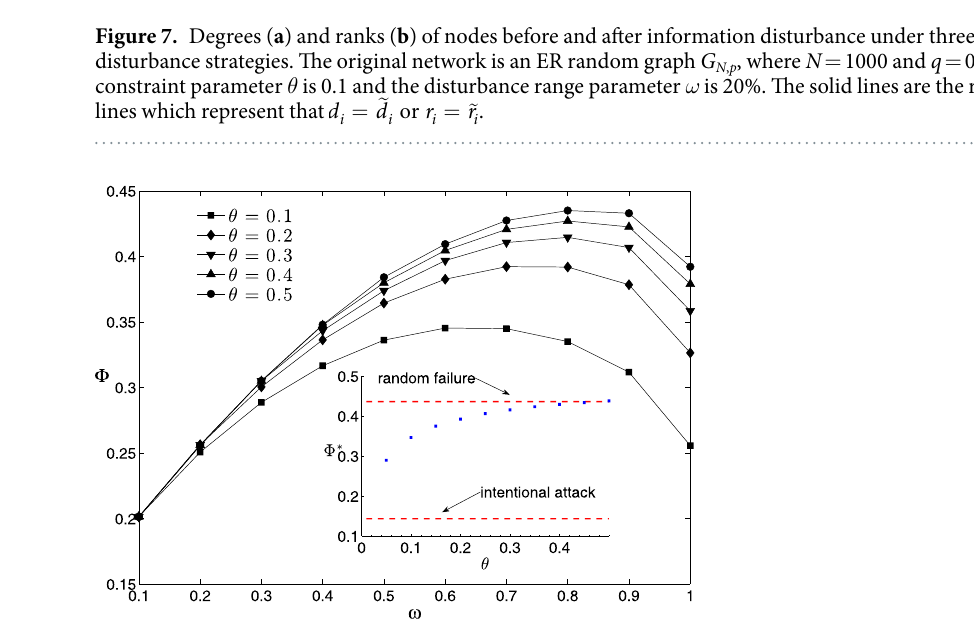
Figure 8. The disturbance effect Φ versus the disturbance range parameter ω under the “poor nodes strategy”. The original network is the same as the one we used in Fig. 2. The symbols represent the original experiment data, which are averaged over 100 realizations of disturbance strategy. The solid lines are obtained from the Kriging surrogate model. The insert shows the maximum disturbance effect Φ * as a function of the cost constraint parameter θ and the cases of random failure and intentional attack as references (dotted lines). The disturbance effect is obtained based on the structural robustness measure R